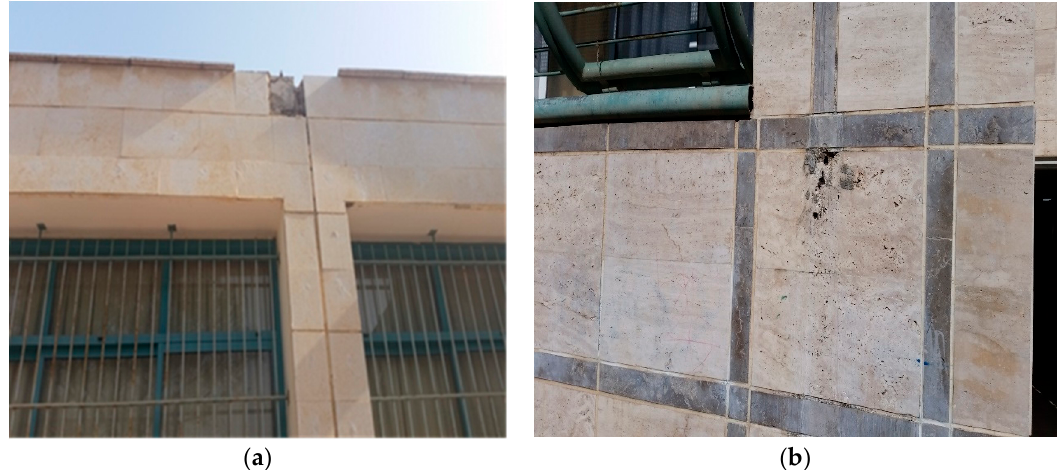
Figure 6. ( a ) Deteriorated exterior stone cladding. ( b ) Cracked stone claddings.